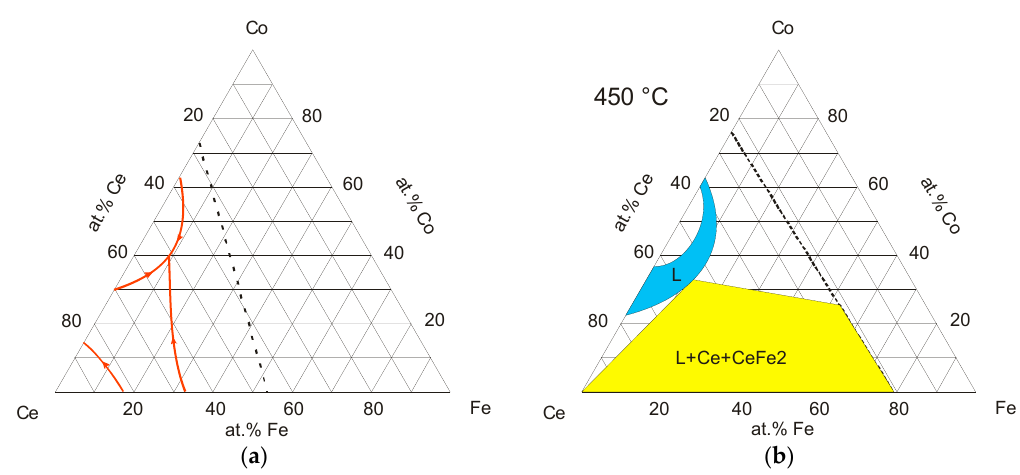
Figure 4. ( a ) Partial liquidus projection of Ce-Co-Fe system [18]; ( b ) partial isothermal section of Ce-Co-Fe system at 450 °C [18].